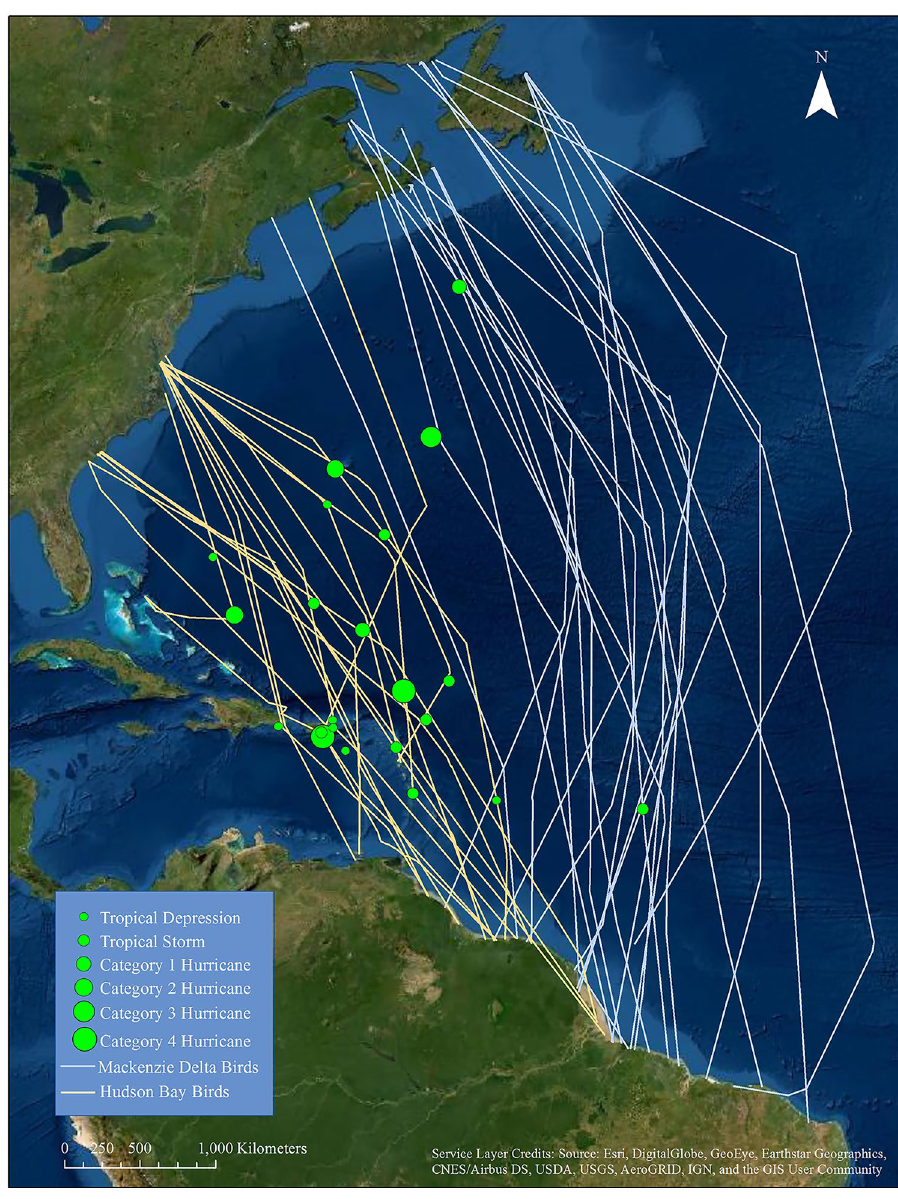
Figure 2. Tracks of autumn trans-Atlantic flights of whimbrels from Mackenzie Delta and Hudson Bay breeding populations. Tracks were recorded for birds fitted with solar-powered satellite transmitters. Symbols represent the locations of whimbrel encounters with tropical cyclones. This figure was produced in ArcGIS 10.7.1 by an author: https:// www. esri.